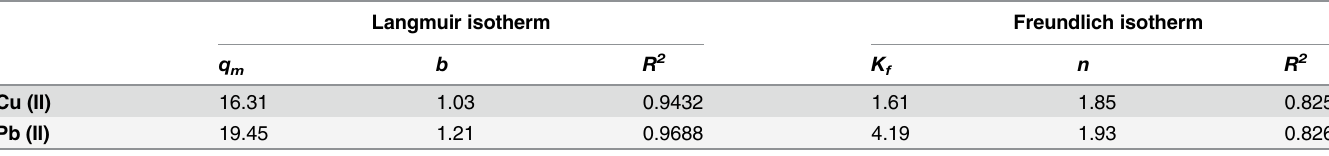
Table 5. Isotherm constants for the adsorption of Cu(II), and Pb(II). Langmuir isotherm Freundlich isotherm q m